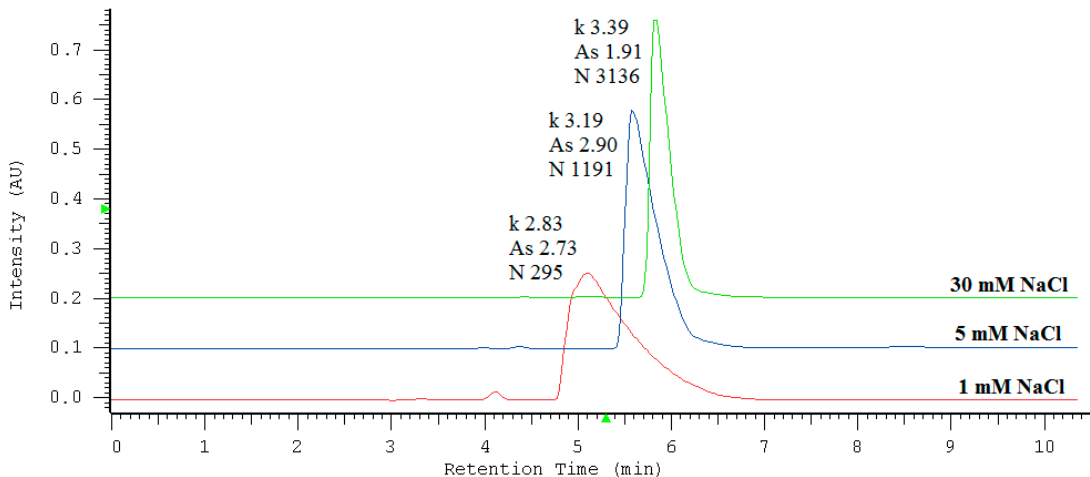
Figure 1. Effect of different concentrations of NaCl in the eluent system on iodide retention, peak symmetry, and efficiency.